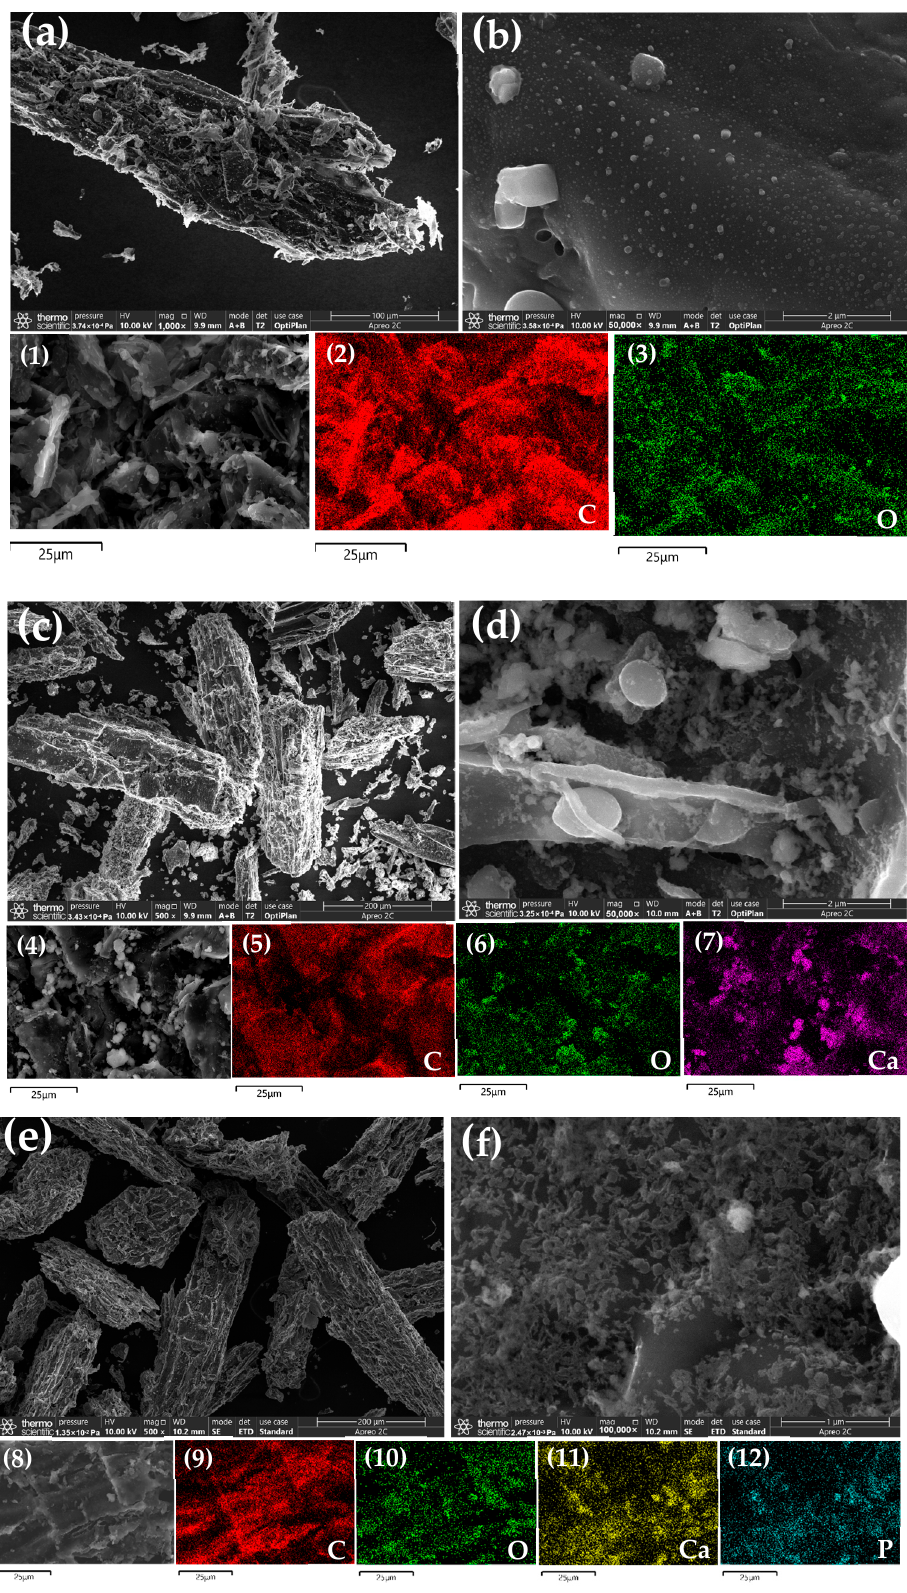
Figure 5. ( a , b ) SEM images of BC, ( c , d ) SEM images of Ca-BC before adsorption, ( e , f ) SEM images of Ca-BC after adsorption, and (1–3) EDS image of BC, (4–7) EDS image of Ca-BC before adsorption, (8–12) EDS image of Ca-BC after adsorption. Table 2. EDS spectrum analysis results of Ca-BC and Ca-BC-P. Ca-BC